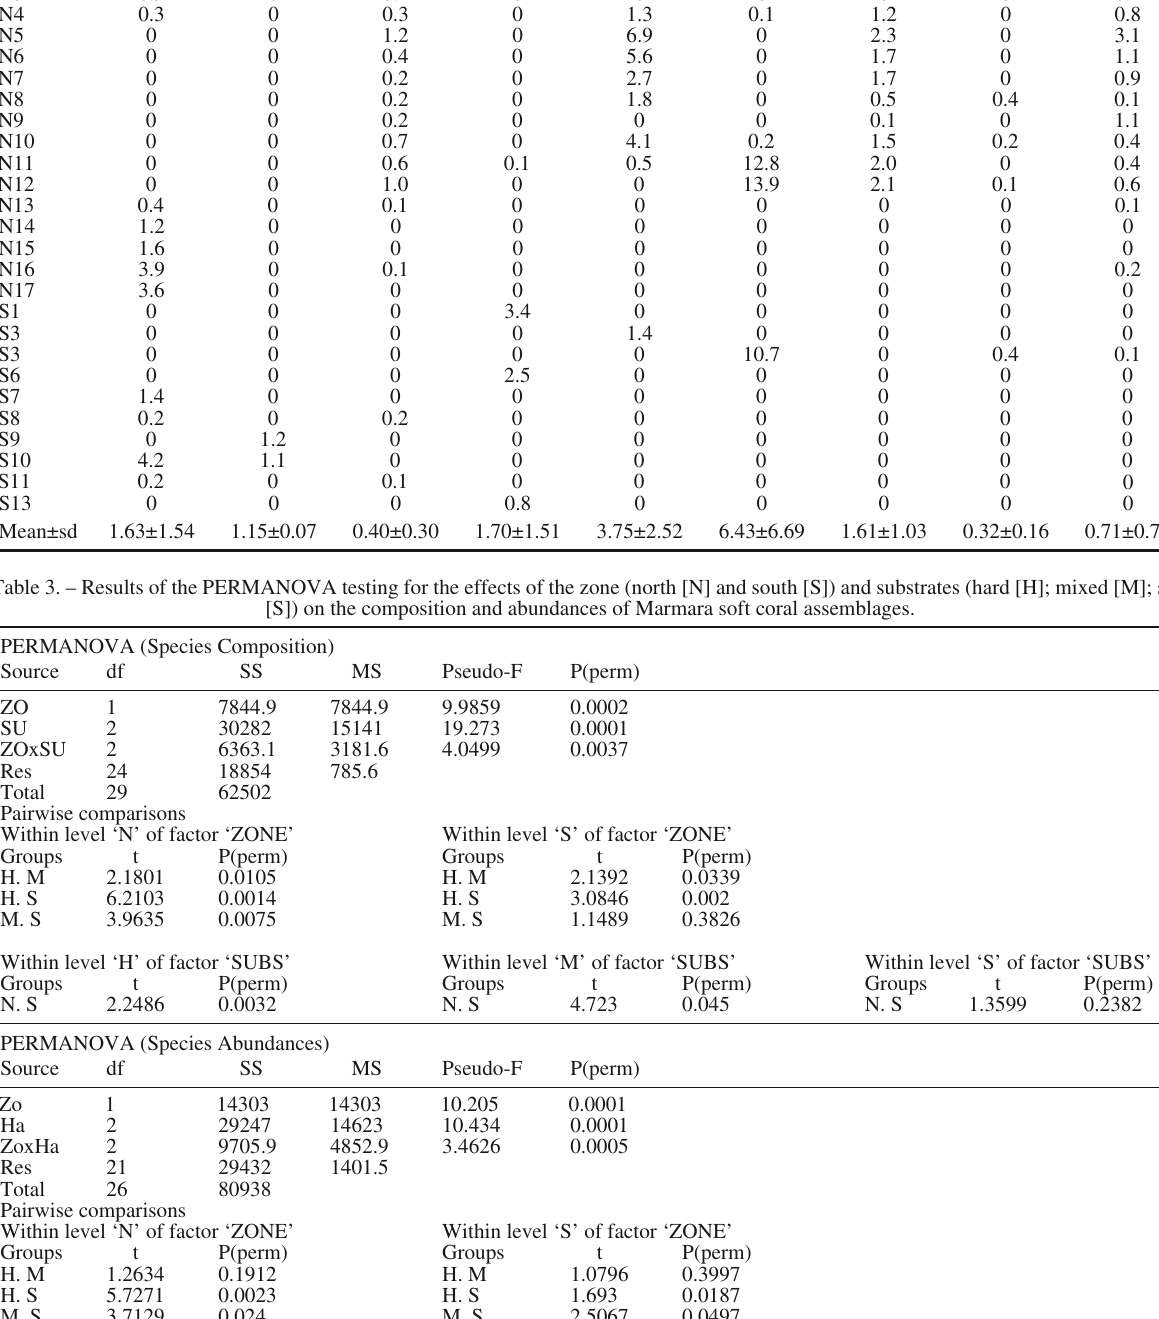
Table 2. – Densities of the species in colonies m –2 and the mean density (± standard deviation) for the stations where the species was present in transect. Species acronyms: AA, Alcyonium acaule ; AP, Alcyonium palmatum ; EC, Eunicella cavolini ; PC, Paramuricea clavata ; PG, Pteroeides griseum ; PM, Paramuricea macrospina ; PS, Paralcyonium spinulosum ; SK, Spinimuricea klavereni ; VC, Veretillum cynomorium .